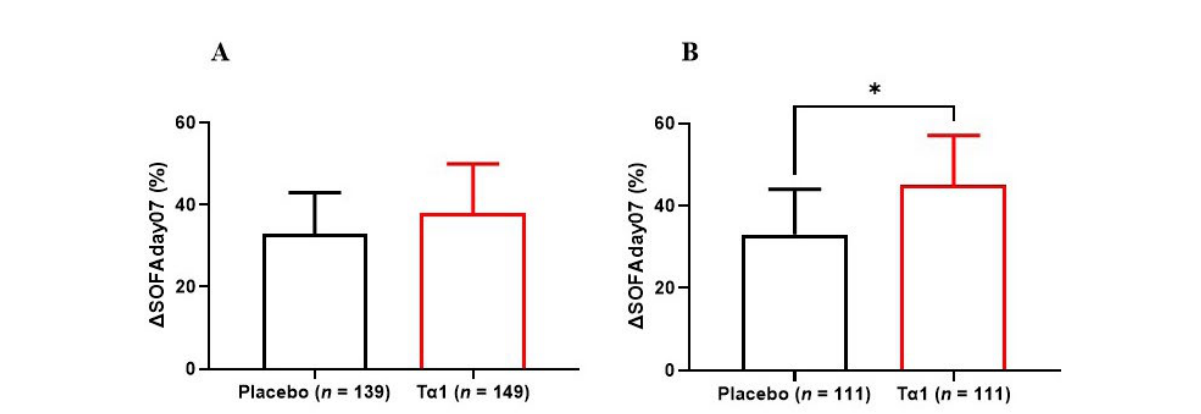
Figure 2. ΔSOFAday07 between Tα1 and placebo group. A: Total patients; B: PSM patients. *: P < 0.05